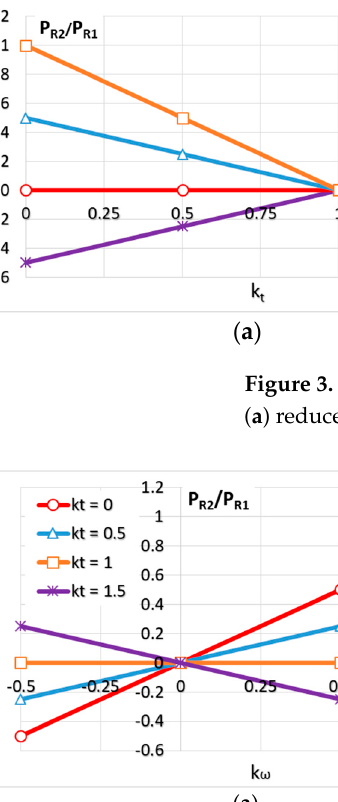
Figure 4. Reduced input power variations depending on the ratio k ω for various values of ratio k t :